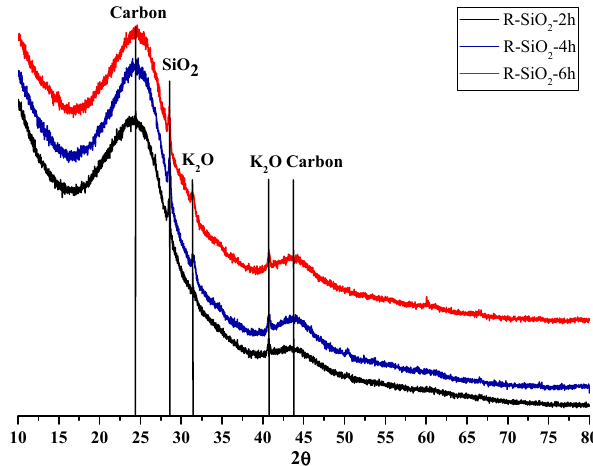
Figure 4. XRD patterns for the biochar–silicates.